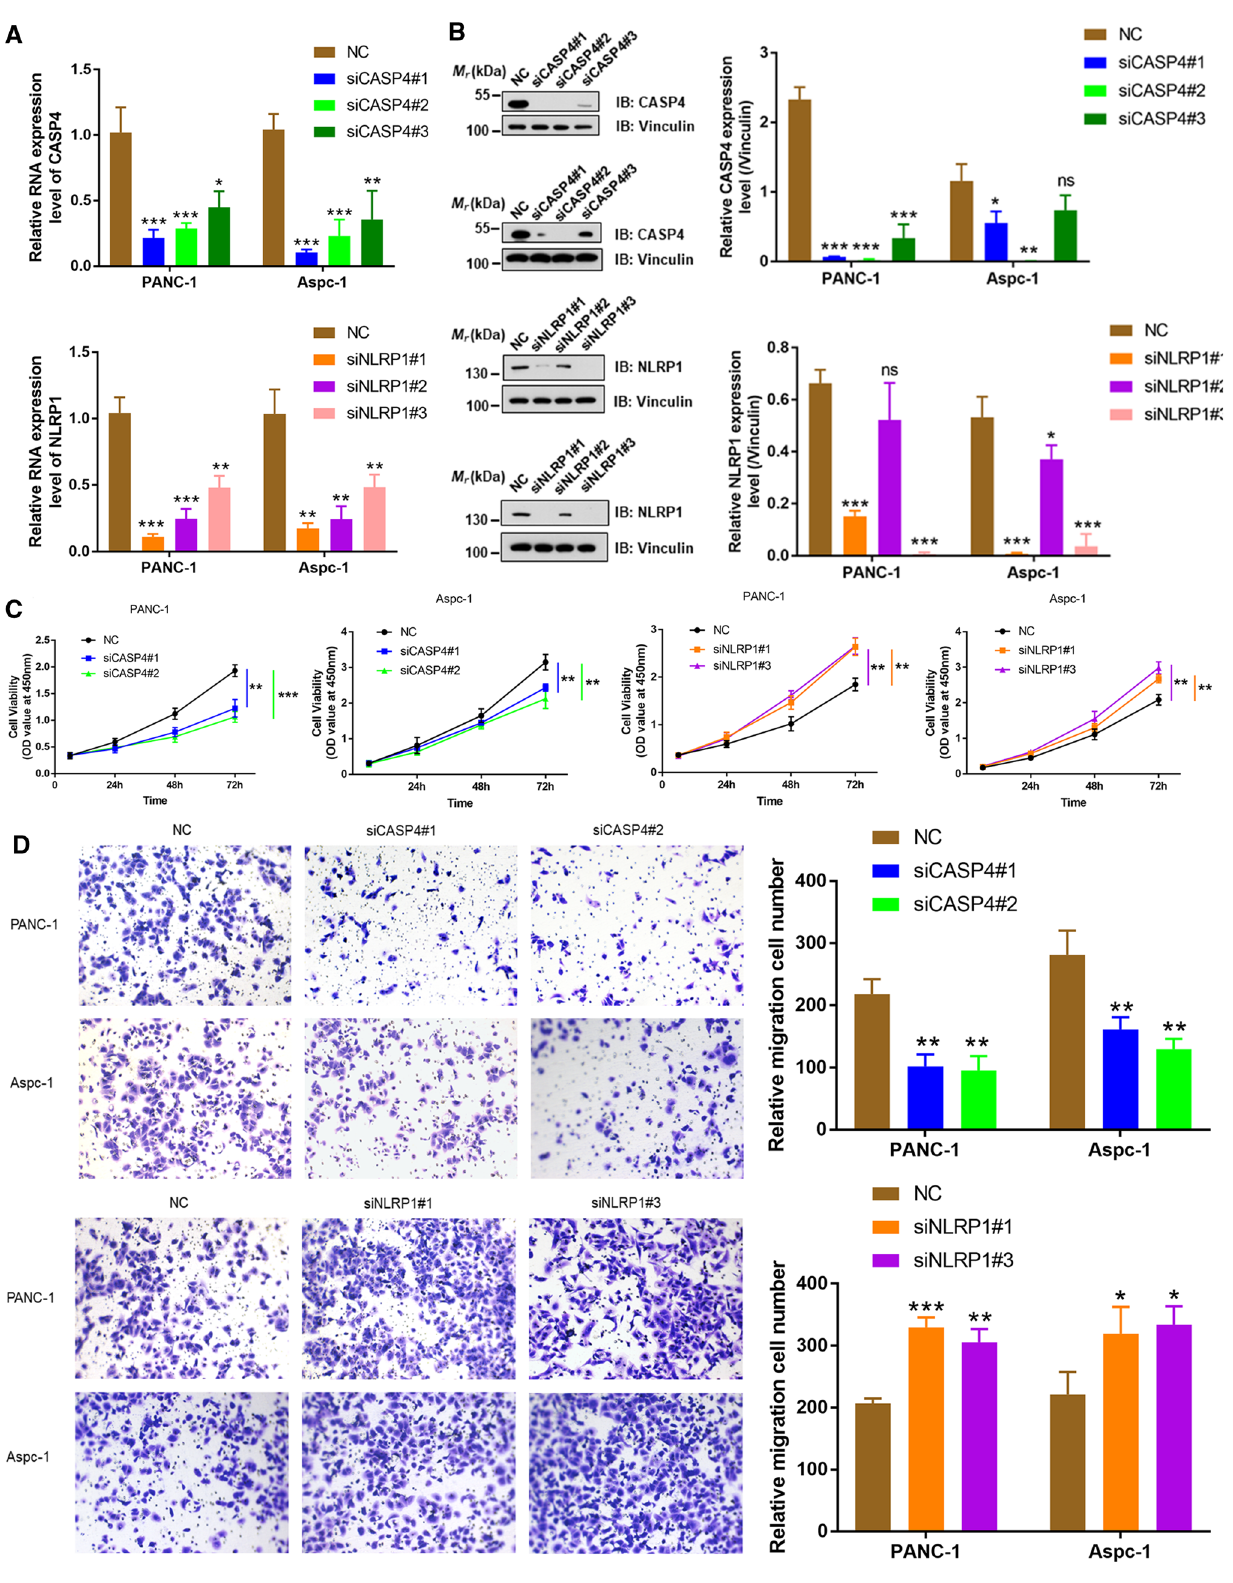
Fig. 6 PRGs regulated the proliferation and invasion of pancreatic cancer cells in vitro. A , B After siRNA transfection, qPCR and western blot was used to detect RNA and protein expression levels of CASP4 and NLRP1 respectively in PANC-1 and Aspc-1 cells. C CCK8 assay was used to detect the proliferation of PANC-1 and Aspc-1 cells after transfection with siRNA. D Transwell was used to detect the change of cell inva- sion ability after transfection with siRNA (*P < 0.05, **P < 0.01, ***P <